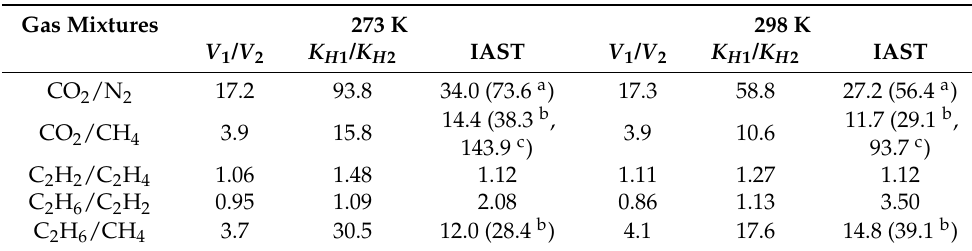
Table 2. Selectivity factors for 1 for separation of equimolar binary gas mixtures evaluated by different